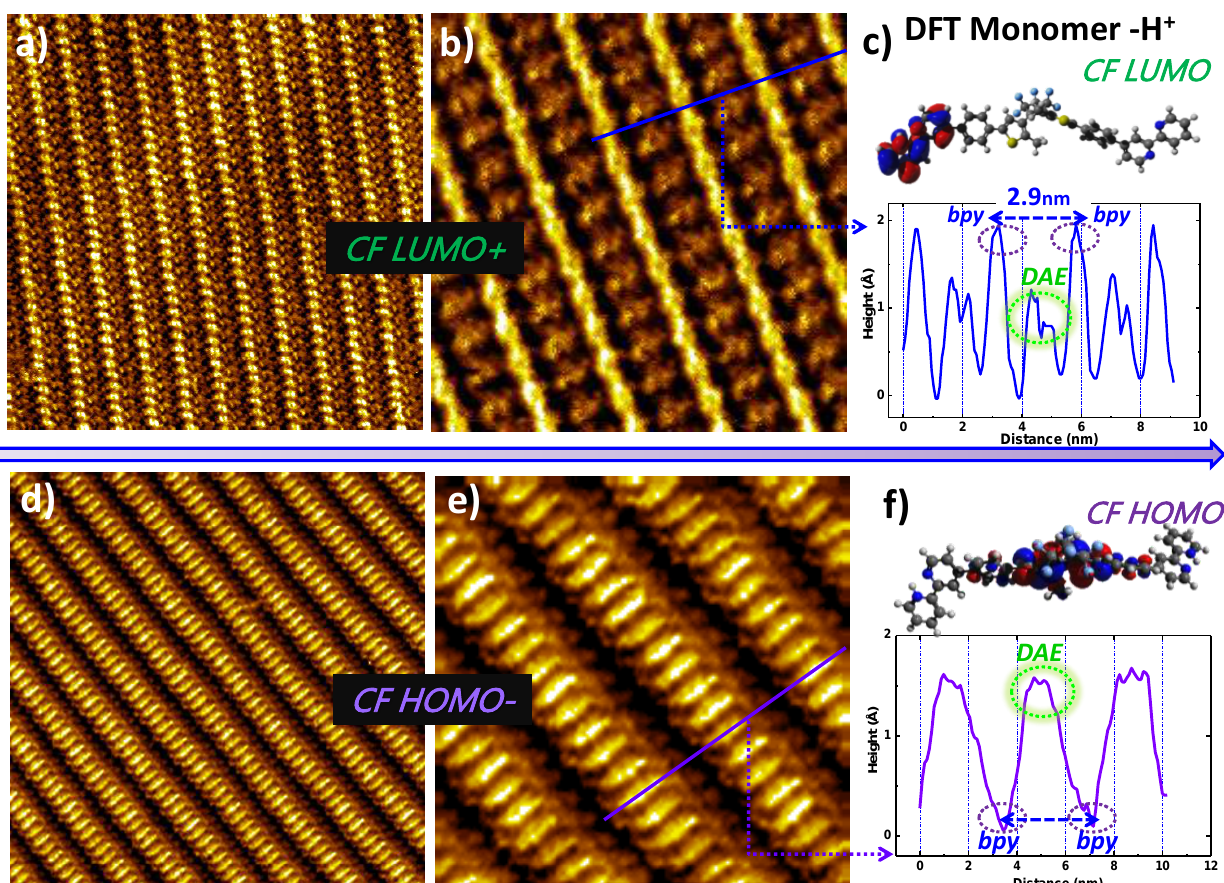
Figure 2. CF bpy-DAE-bpy network at 1-heptanoic acid/HOPG interface, I t = 15~30 pA, U s = − 0.45~ − 0.7 V: STM images of DOS attributed to LUMO orbitals ( a ) 35 × 35 nm 2 ; ( b ) 14 × 14 nm 2 . ( c ) Line profile image and DFT-calculated monoprotonated LUMO orbital. Images of HOMO orbitals: ( d ) 35 × 35 nm 2 ; ( e ) 14 × 14 nm 2 . ( f ) Line profile image and calculated HOMO orbital.